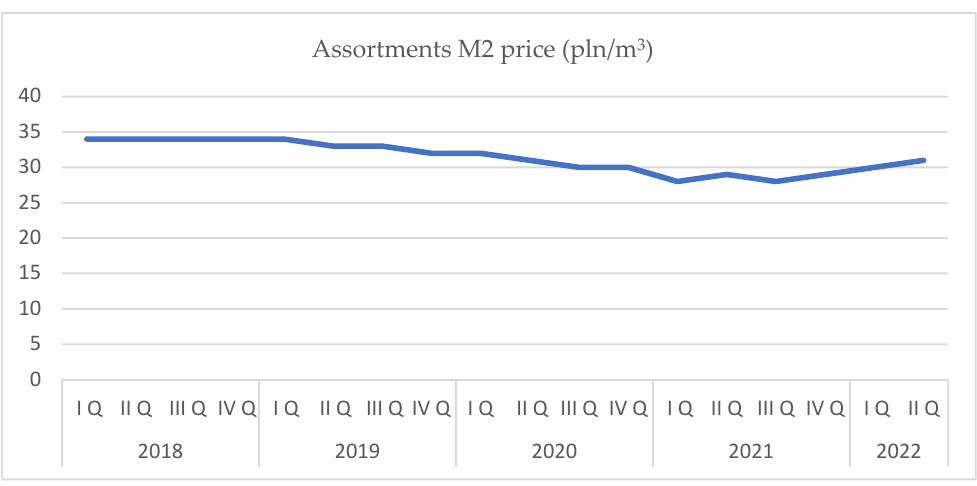
Table 2. Price forecast for the M2 assortment in Q3 of 2022, Q4 of 2022, and Q1 of 2023. Source: Own elaboration based on data obtained from the State Forests IT System (SILP).